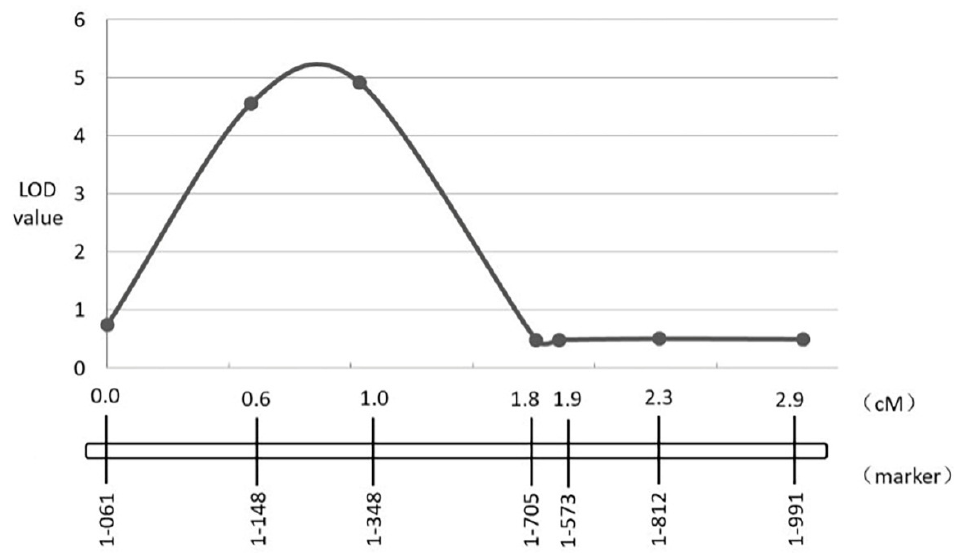
Figure 6. Identification and validation of CR QTL Bcr2 on chromosome A08.